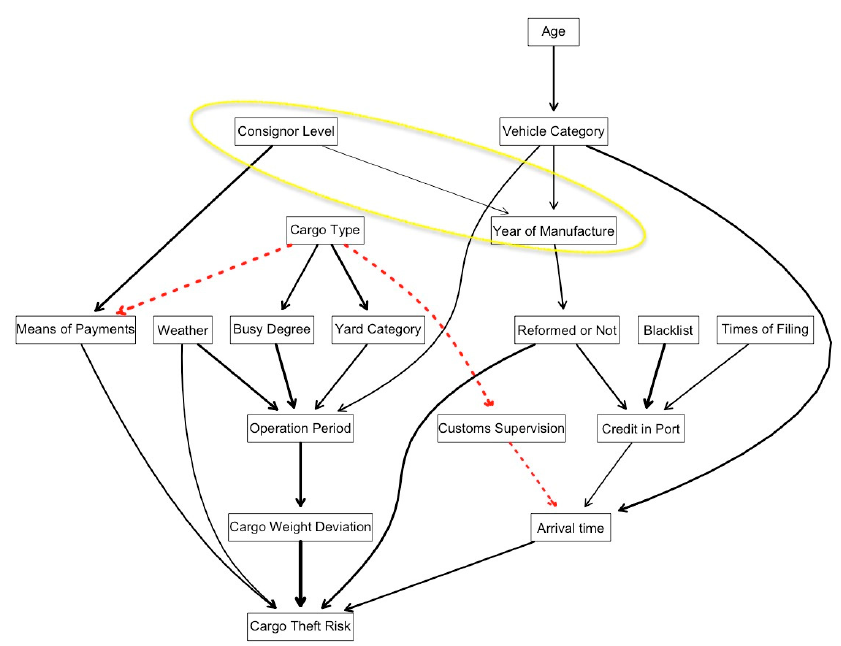
Figure 6. The Bayesian network structure derived using combinations of heuristic structure search algorithm with TABU and score function with algorithm with TABU and score function with k2.